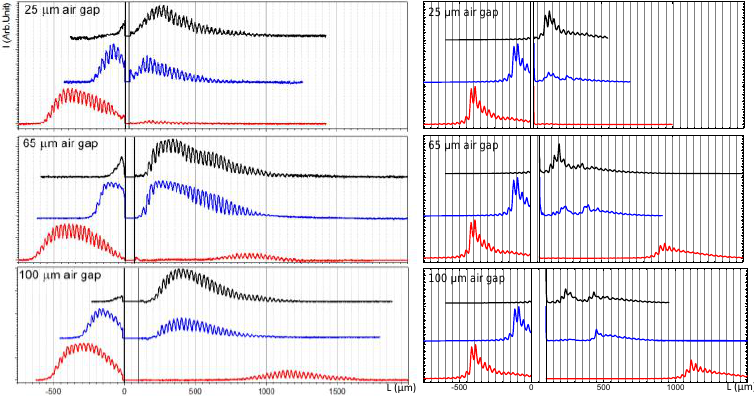
Fig. 1. Density profiles of the CCs recorded in experiments (left side). Calculated plasma density distributions in a channel during the propagation of a single-cycle LB at the same conditions (right